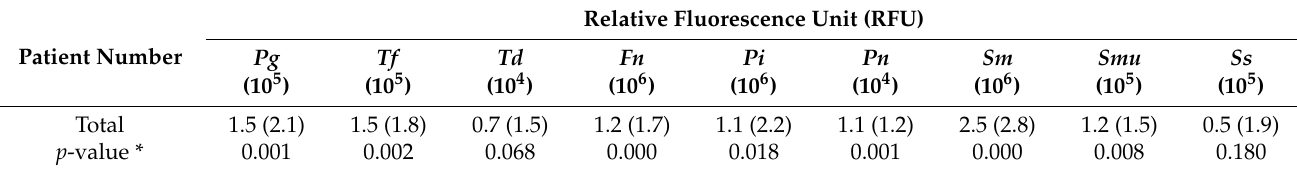
Table 2. Absolute quantitative changes in the oral microbial species of oral lichen planus patients before and after treatment with dexamethasone gargle.